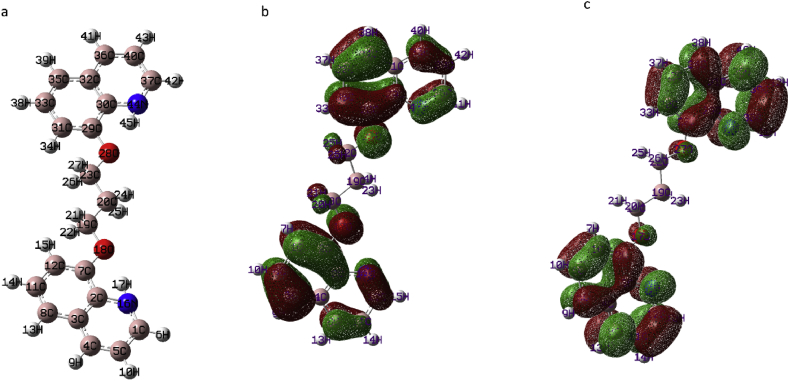
a) The optimized geometric structures of BQYP molecules. (b) The geometric structure of the HOMO orbital and c) LUMO orbital.